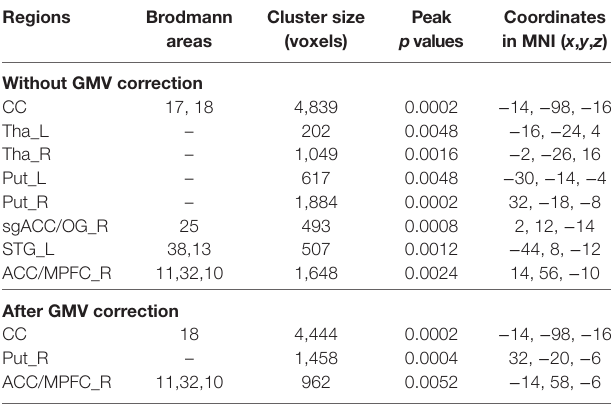
TaBle 2 | Brain regions with significant group differences in CBF.